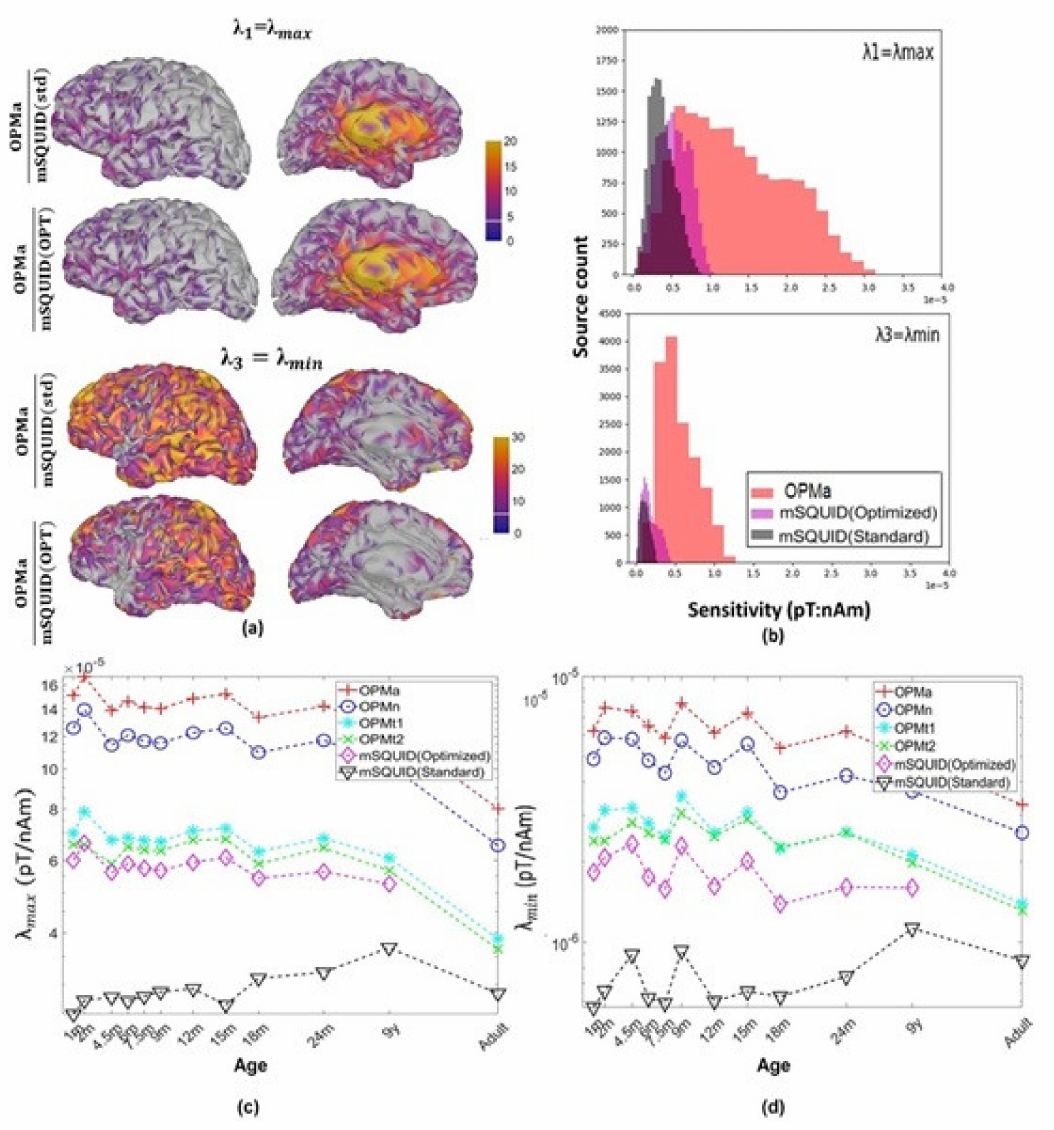
Figure 6. ( a ) The relative sensitivity of the arrays to the orthogonal source components at each location on the cortex, as indicated by the singular values of the dipole gain matrix for the nine-year- old subject. ( b ) Histograms for λ min and λ max at all locations on the cortex, for the same subject. ( c , d ) Distribution of the sensitivity for λ max and λ min , by subject